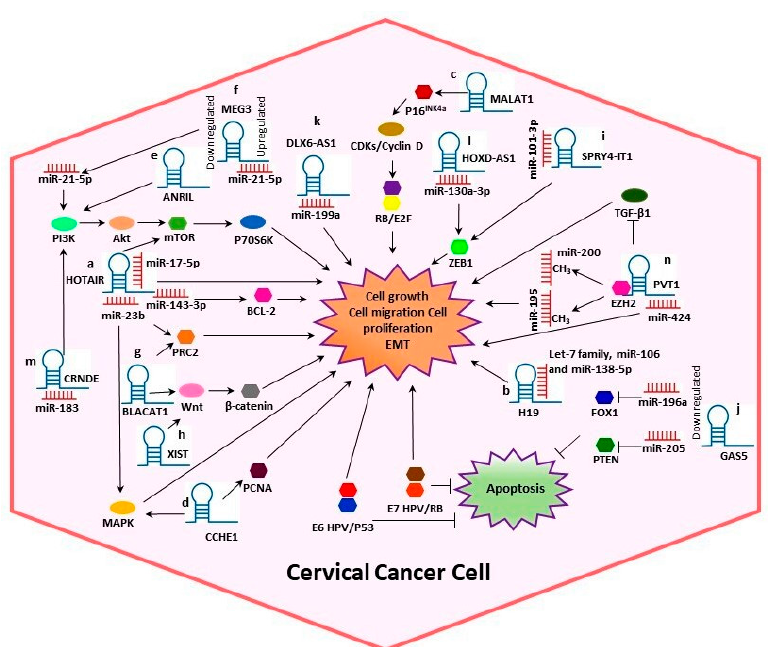
Figure 2. Potential mechanisms of several lncRNAs in CC. Some lncRNAs play significant roles in CC progression by sponging miRNAs and interacting with other proteins, altering the cell cycle. ( a )